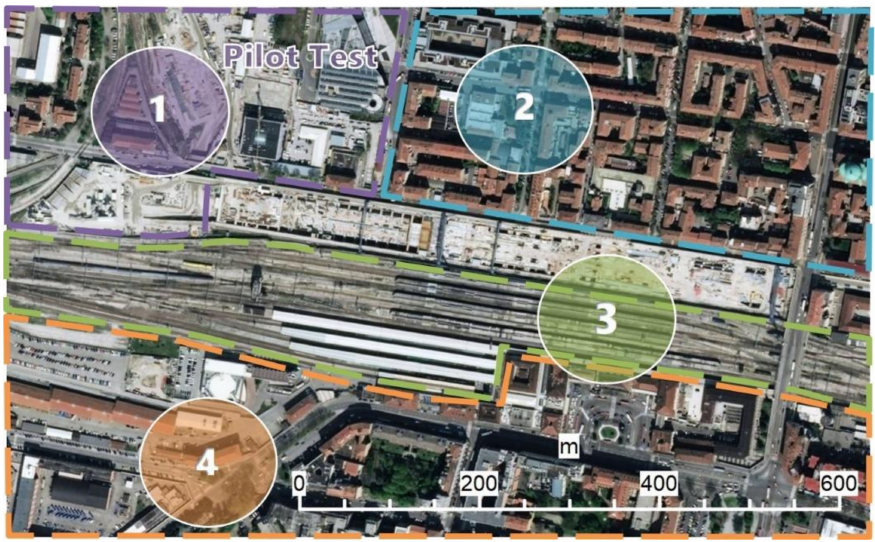
Figure 8. Identification of the pilot test and other intervention